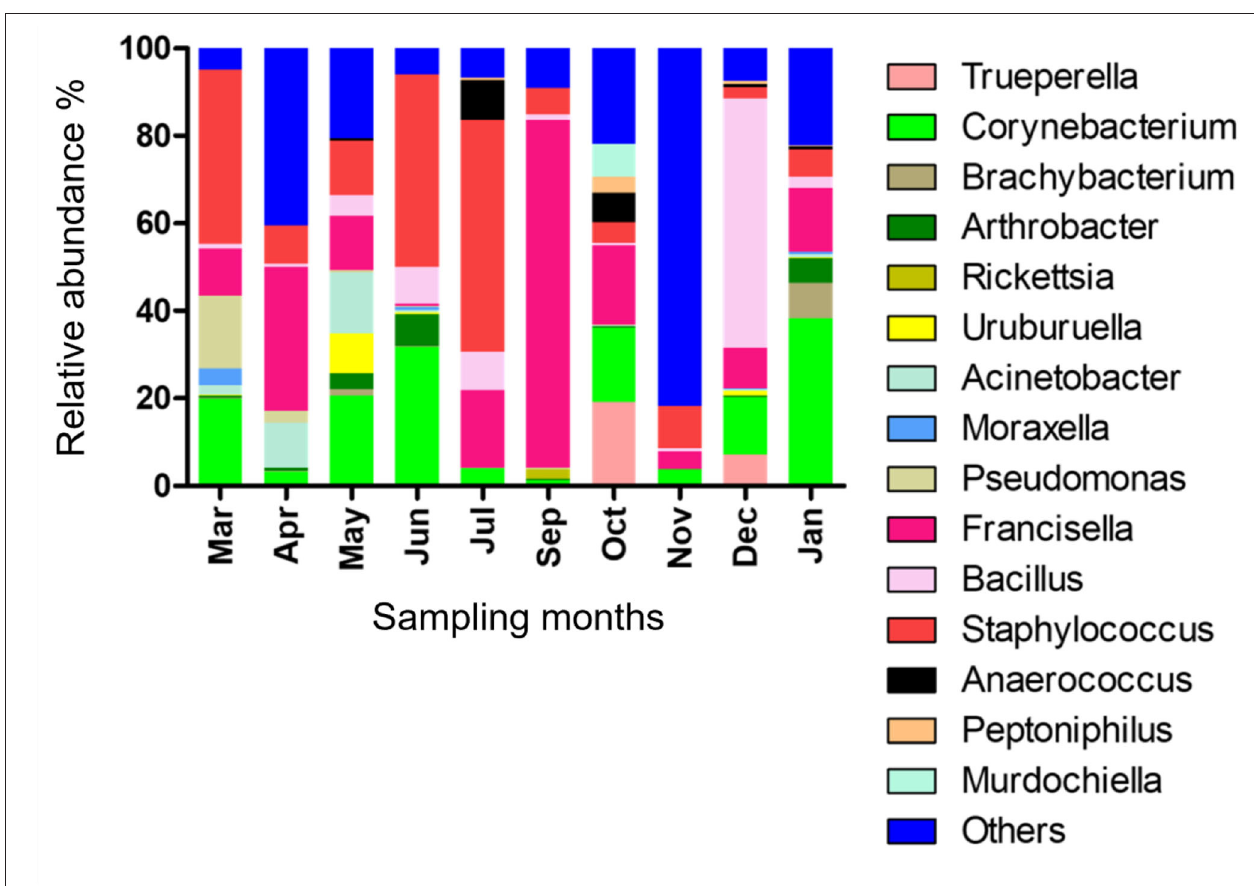
FIGURE 2 | Microbial genera detected in H. dromedarii partially engorged female ticks from 10